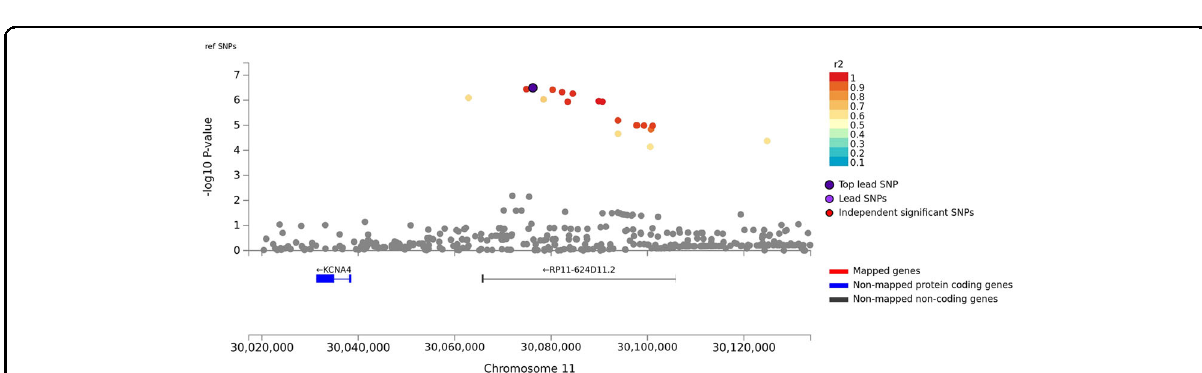
Fig. 3 Association of stimulant dependence with SNPs located in the KCNA4 region in the African American discovery sample. SNPs are color-coded according to the correlation coef fi cient ( r 2 ) in the 1000 Genomes African reference panel with the top-ranked SNP, rs11500237 located 93 kb upstream of KCNA4 . Rs11500237 was nearly genome-wide signi fi cant ( P = 2.99 × 10 − 7 ) after meta-analysis with the replication